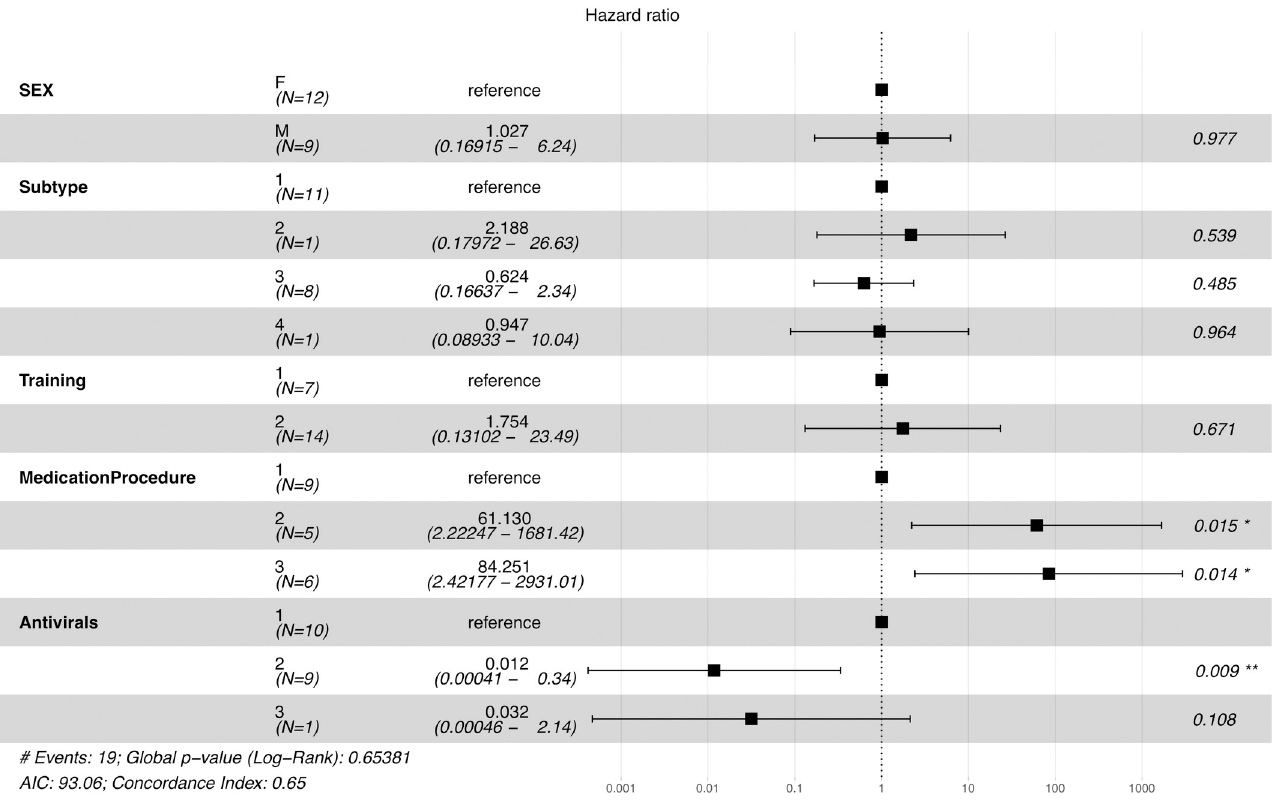
PLOS ONE | https://doi.org/10.1371/journal.pone.0219288 July 5,